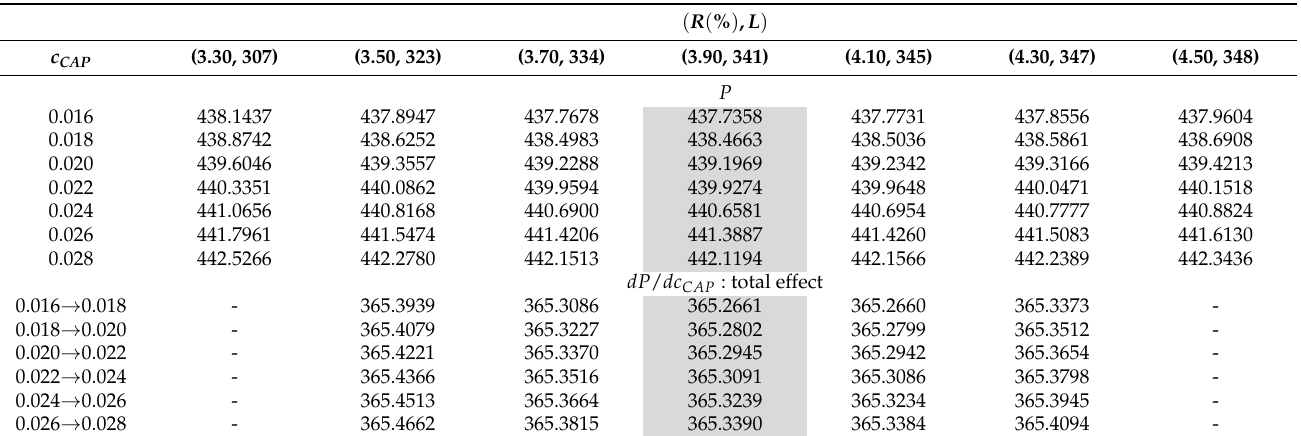
Table 4. Responsiveness of P to c CAP